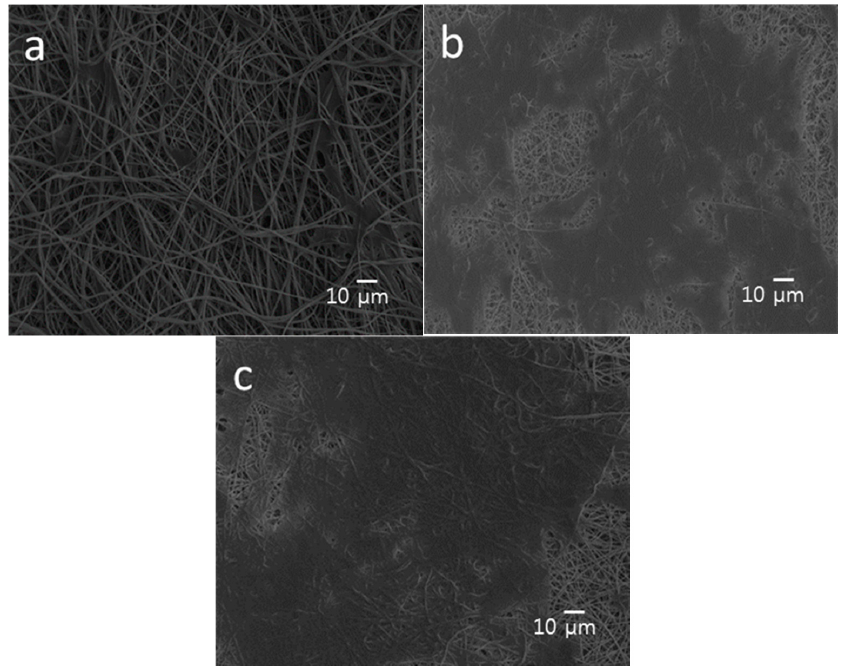
Figure 11. SEM images showing the attachment of osteoblasts on ( a ) PLA; ( b ) PLA/15%nHA and ( c ) PLA/15%nHA-2%GO fibrous mats.